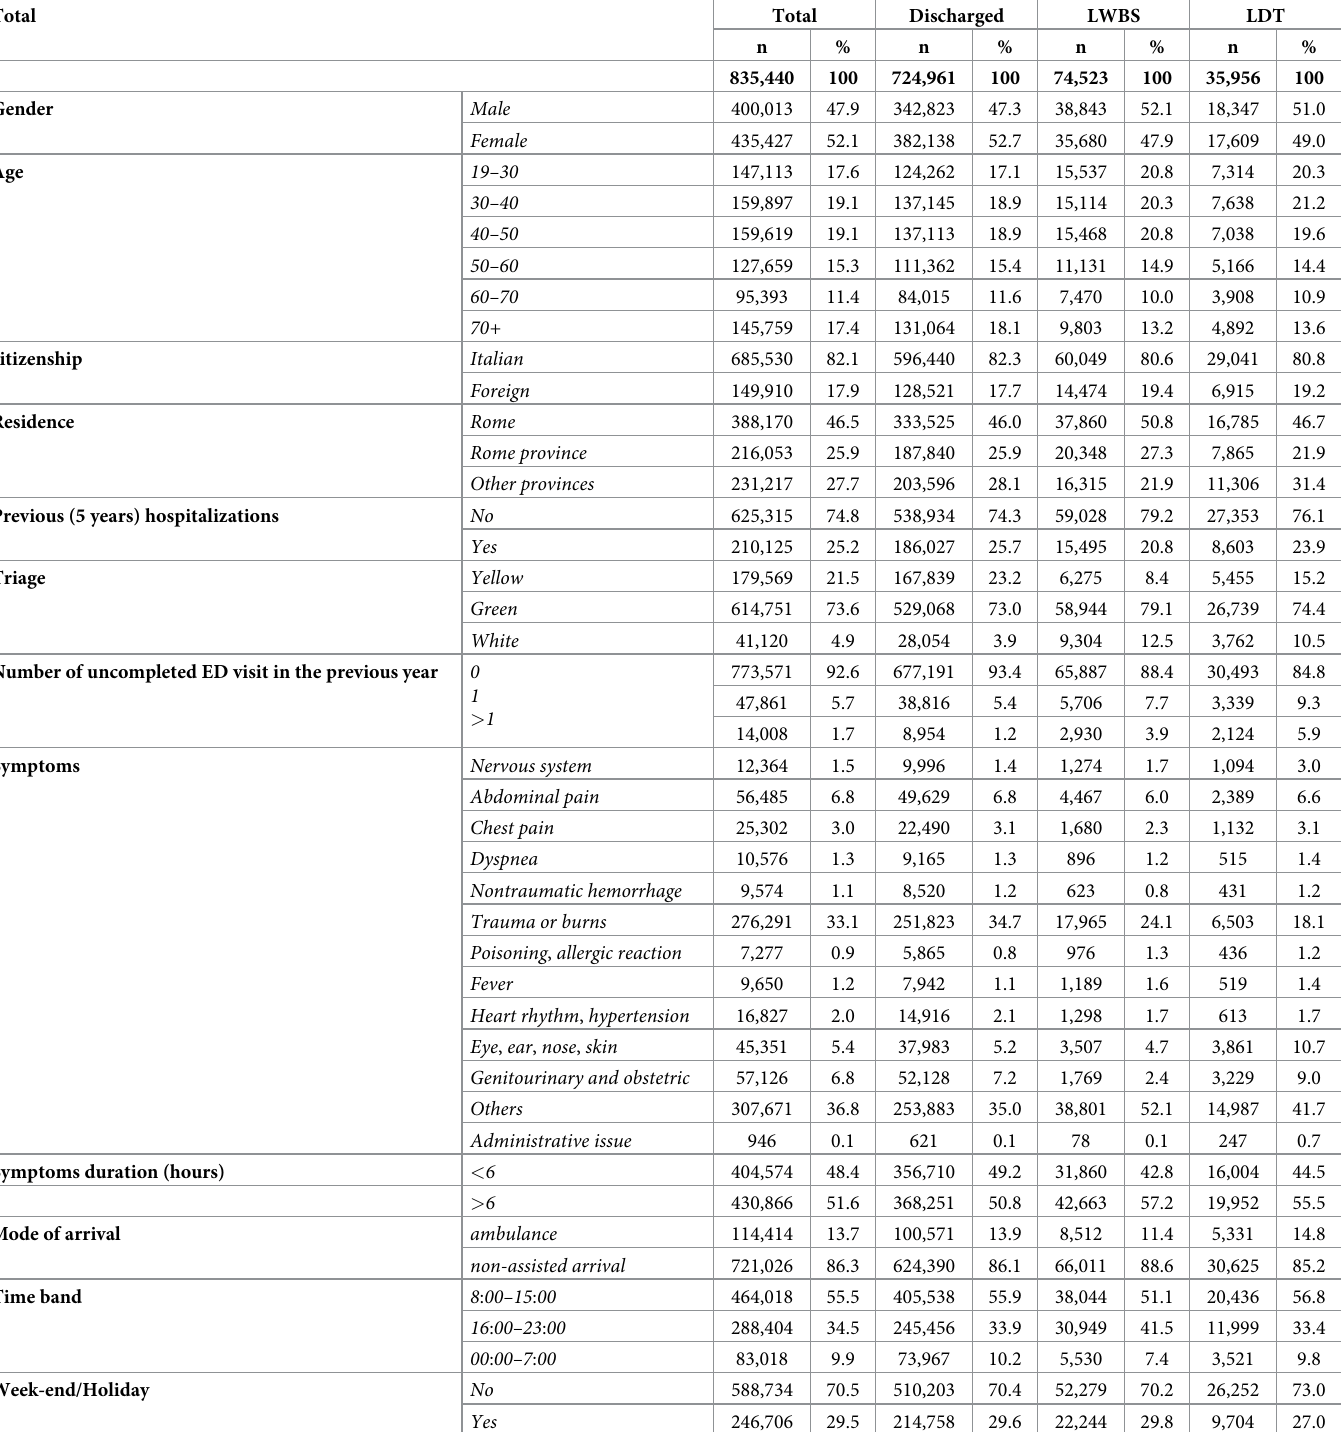
Table 1. Characteristics of the overall study cohort (Total ED visits), and separately for visits of subjects visited and discharged, those who left the ED without being seen (LWBS) or during the treatment (LDT).